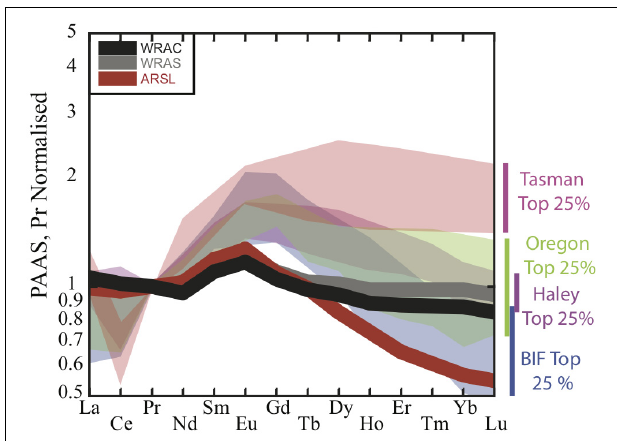
FIGURE 6 | Range of shale-normalized REE patterns of pore water source depths from the Tasman Sea (this study) and available published pore water data (Haley et al., 2004; Abbott et al., 2015b). The most HREE enriched range is observed in the Tasman Sea, where REE concentrations were the lowest overall. Average river suspended load (ARSL, red), world river average clay (WRAC, gray), and world river average silt (WRAS, black) plotted for comparison (data from Bayon et al., 2015). Normalized to PAAS values of Taylor and McLennan (1985).